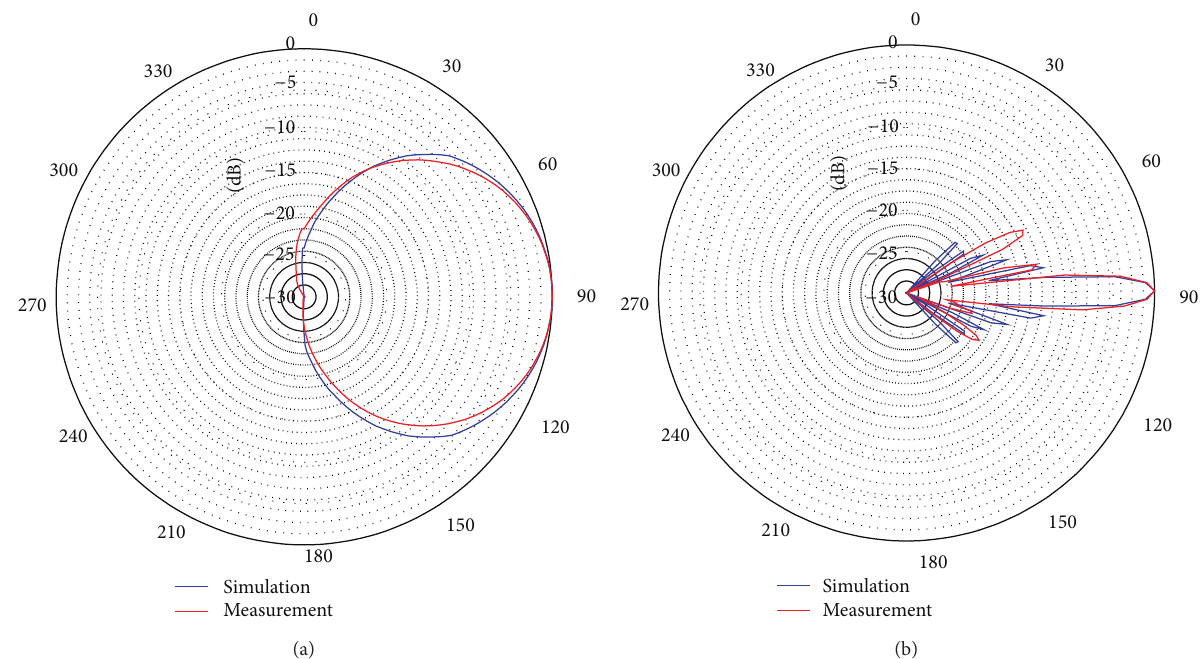
Figure 7: Comparison of radiation patterns at 2060 MHz on the horizontal and vertical planes obtained by FDTD method and measurement.